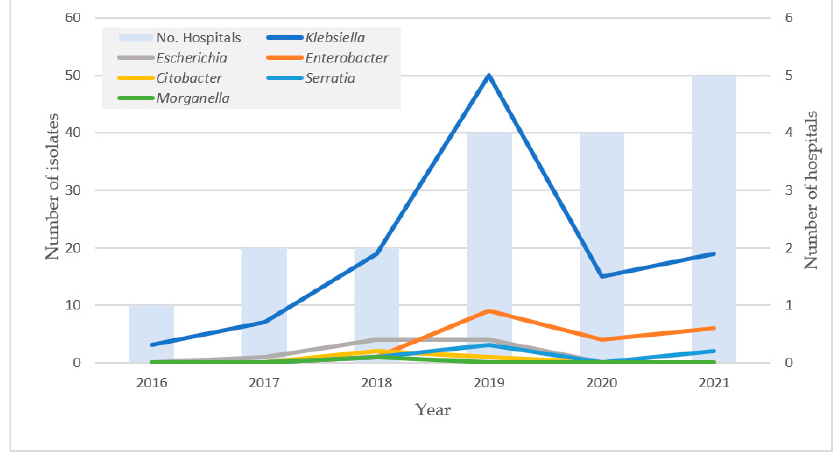
Figure 2. Distribution of CPE genera per year (total 152 isolates) and number of hospitals (total 10 hospitals) (Pedro Kourí Institute, from 2016 to 2021).